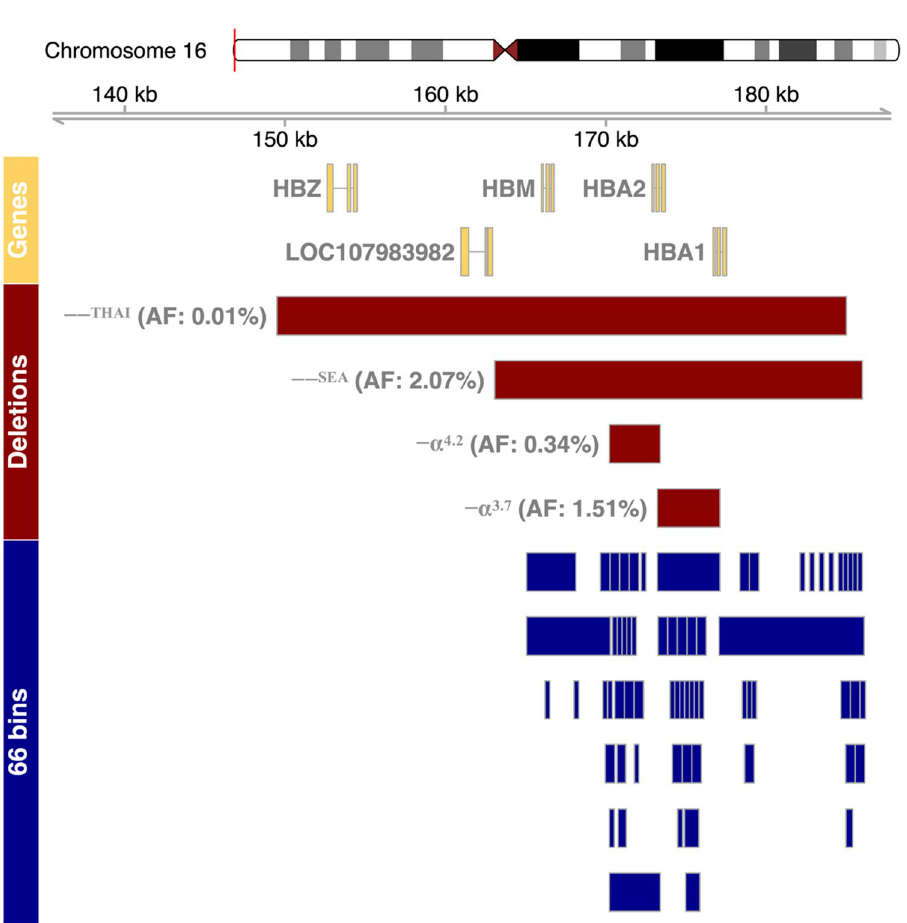
Figure 2. The human α-globin gene cluster and the mutations detected. The Genes track panel illustrates the α-globin locus on the tip of chromosome 16. The approximate ranges of the four deletions (red bar) detected in this study population (−− SEA , −α 3.7 , α 4.2 and −− THAI ) are shown in the “Deletions” track. The ranges of 66 bins (blue bars) within the α-globin gene cluster are shown in the “66 bins” track. The counts of fragments mapped to each bin were used as the raw data for our prediction model. −− SEA , Southeast Asian deletion; −− THAI , Thailand deletion; AF, Allele frequency. The figure was drawn using the Gviz